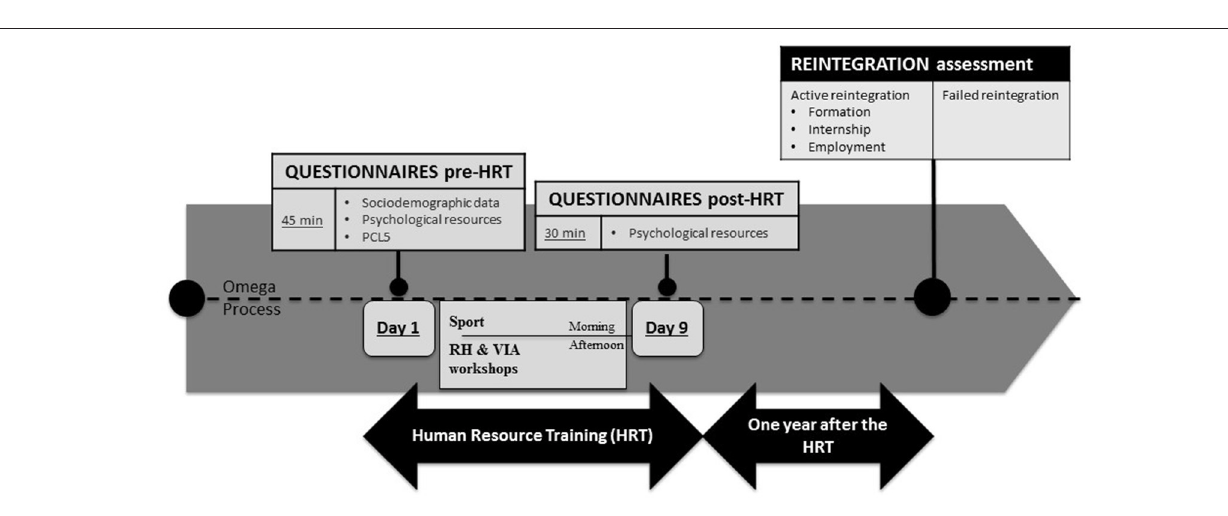
reintegration program, two main positive psychology